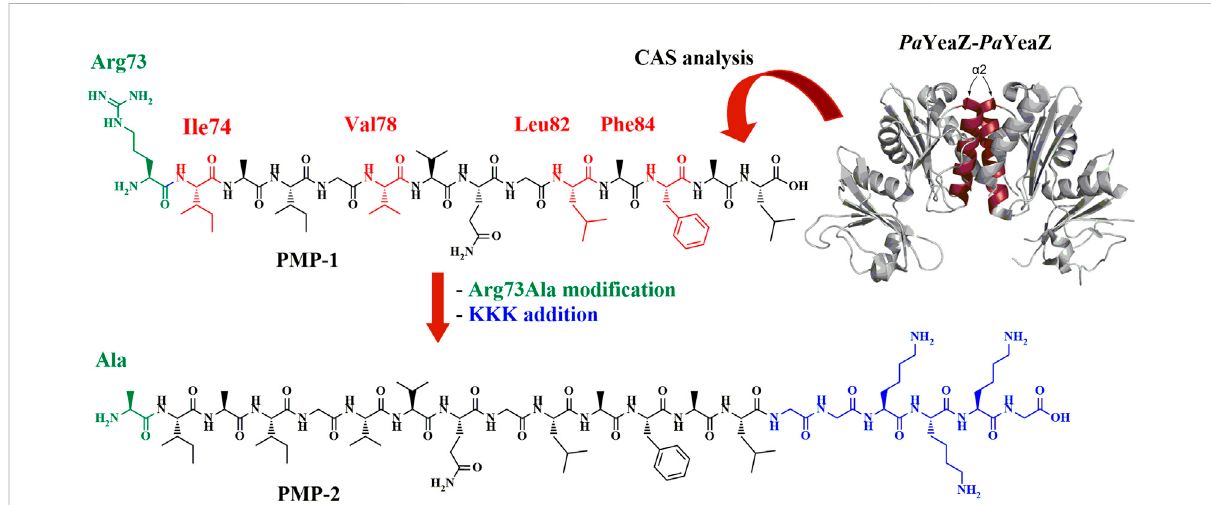
FIGURE 1 Pa YeaZ dimer crystal structure (PDB: 4Y0W, the two α 2 helix of each subunit are colored in ruby red), the computationally identi fi ed PMP-1 sequence (Arg73-Leu86) and the fi nal amphiphilic PMP-2, object of this study. Hot spots are shown in red in PMP-1, further Arg73Ala modi fi cation is highlighted in green and GGKKKG C-terminal sequence is shown in